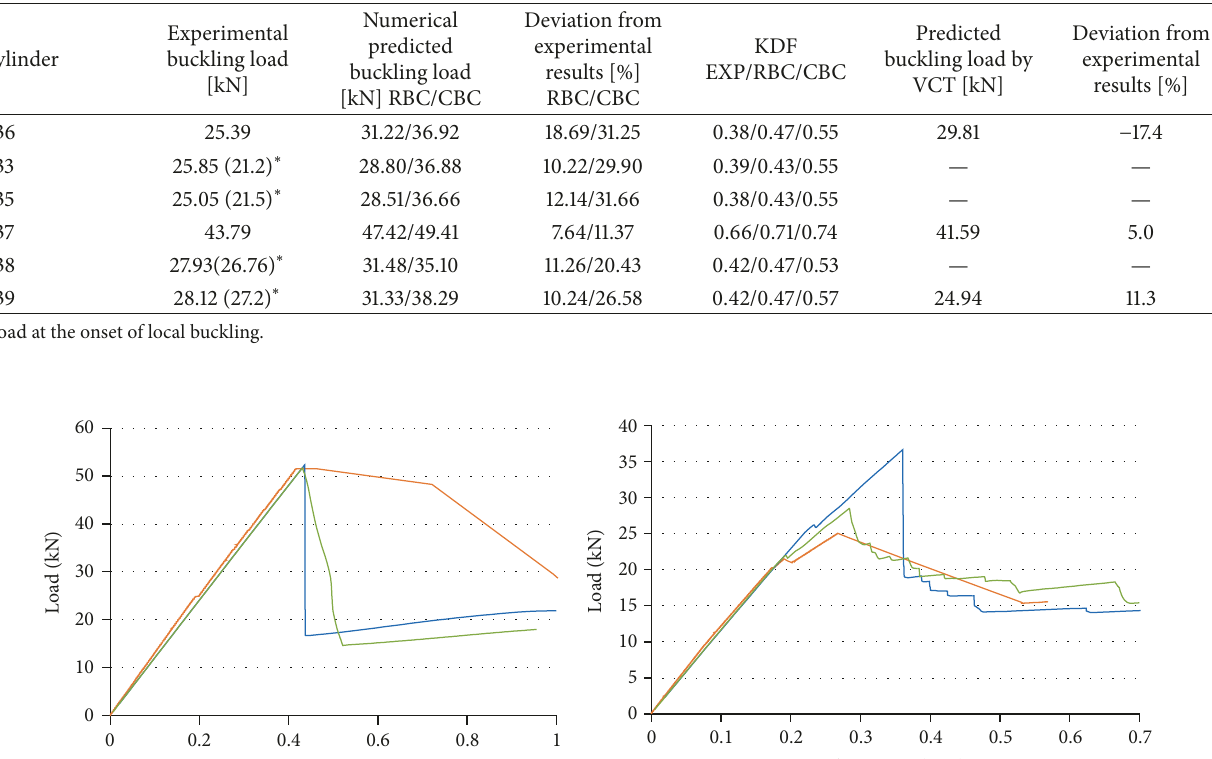
Table 5: Numerical buckling load prediction and VCT results for shells with cutouts.